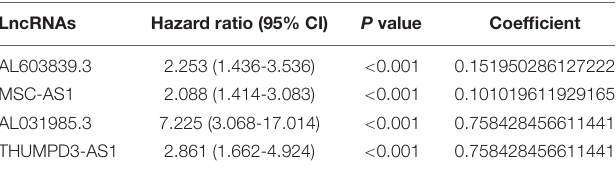
TABLE 2 | The four immune LncRNAs screened out by univariate Cox regression and LASSO regression analysis. LncRNAs Hazard ratio (95%